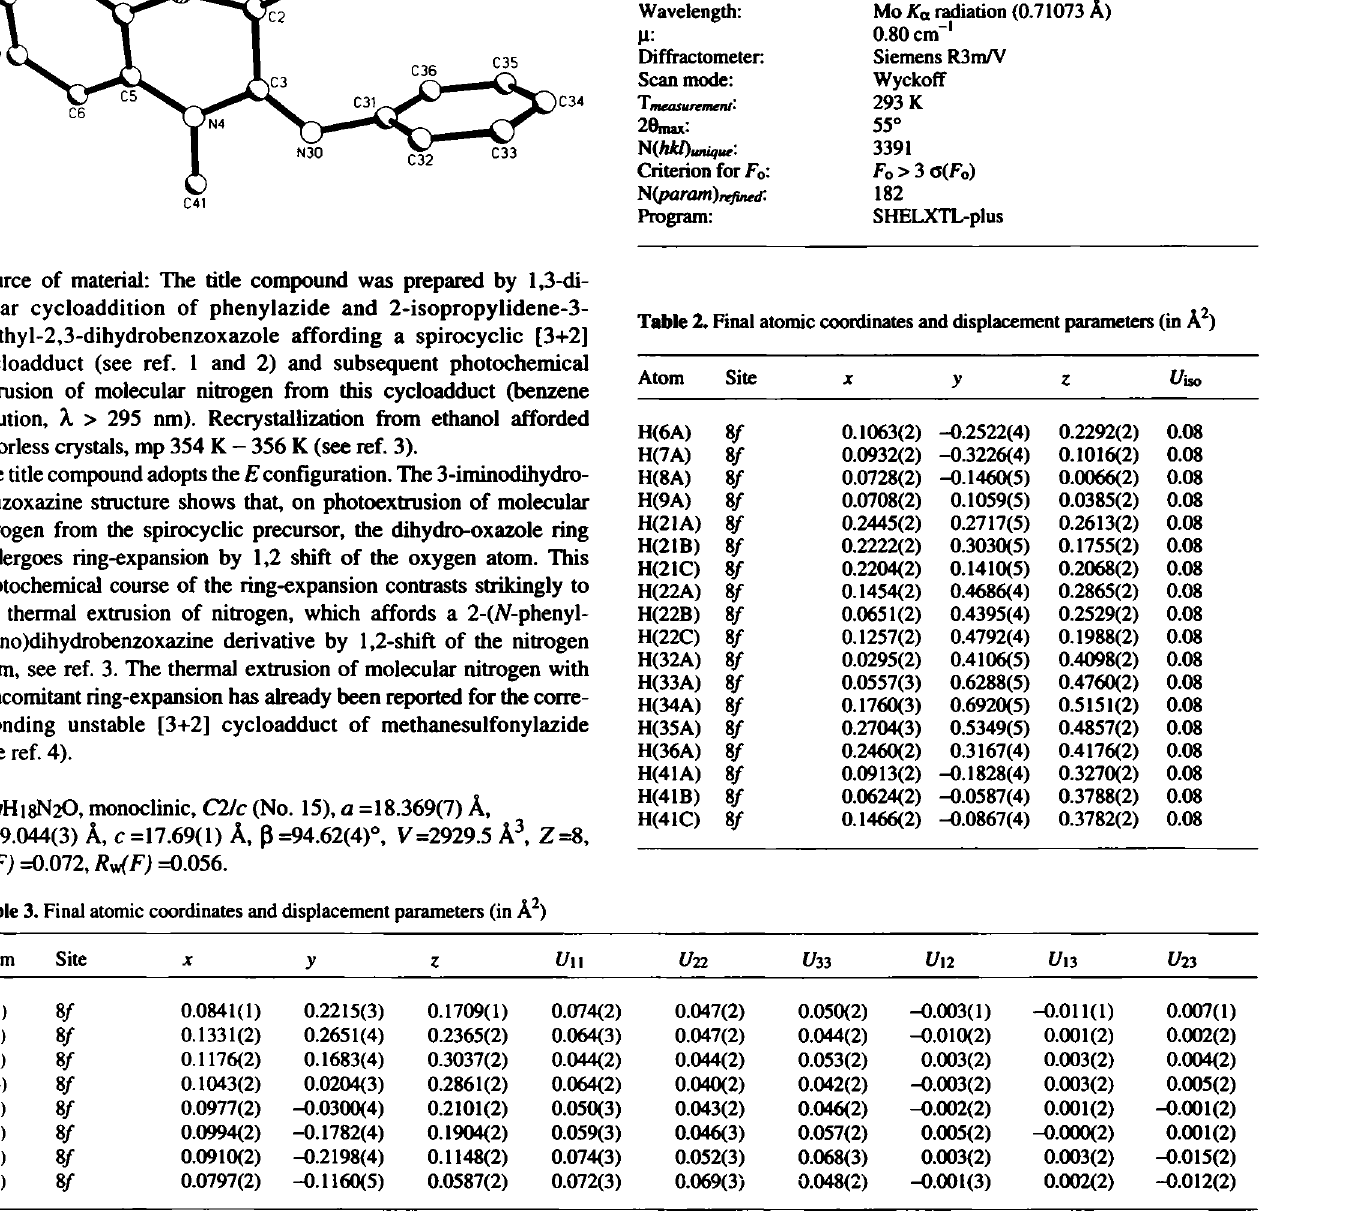
Table 1. Parameters used for the X-ray data collection